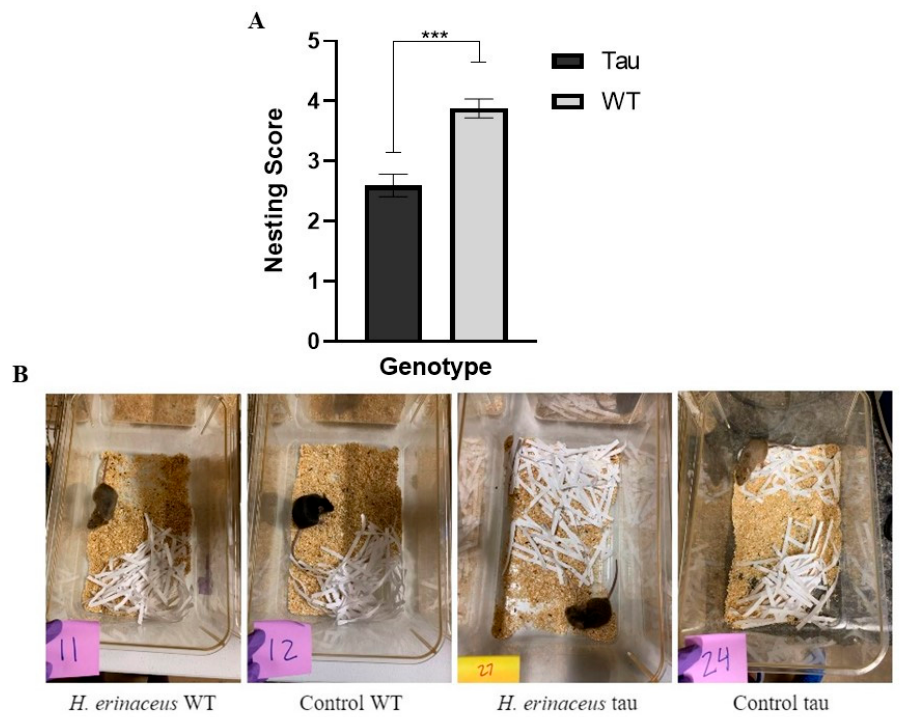
Figure 14. Nesting behavior. ( A ) WT mice built significantly better nests than tau mice. ( B ) Repre- sentative nest by mushroom condition and genotype; numbers represent randomly assigned IDs for raters. Error bars represent mean ± SEM (*** p <